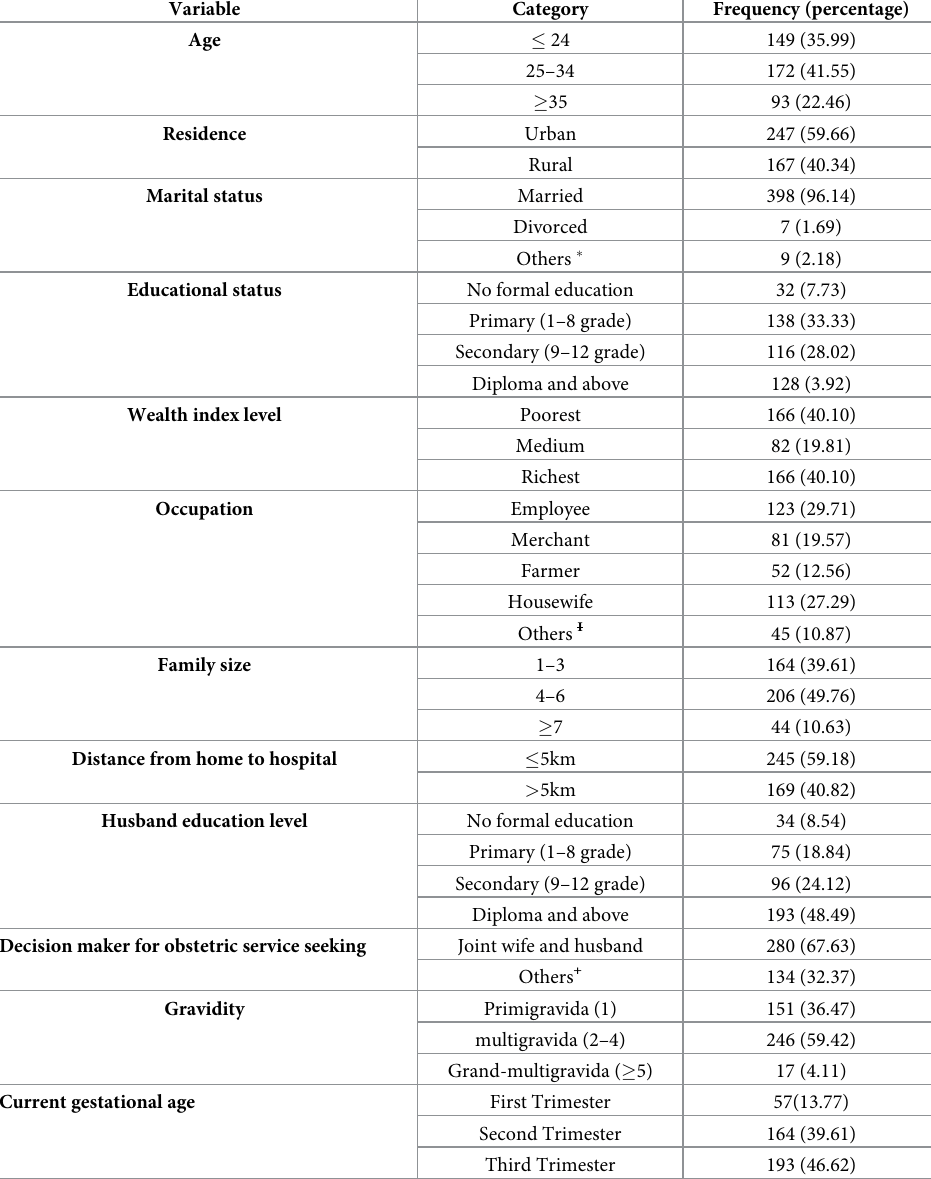
Table 1. Socio-demographic characteristics of pregnant women attending antenatal care service at North Shewa zone public hospitals, Oromia region, central Ethiopia, 2021 (n =